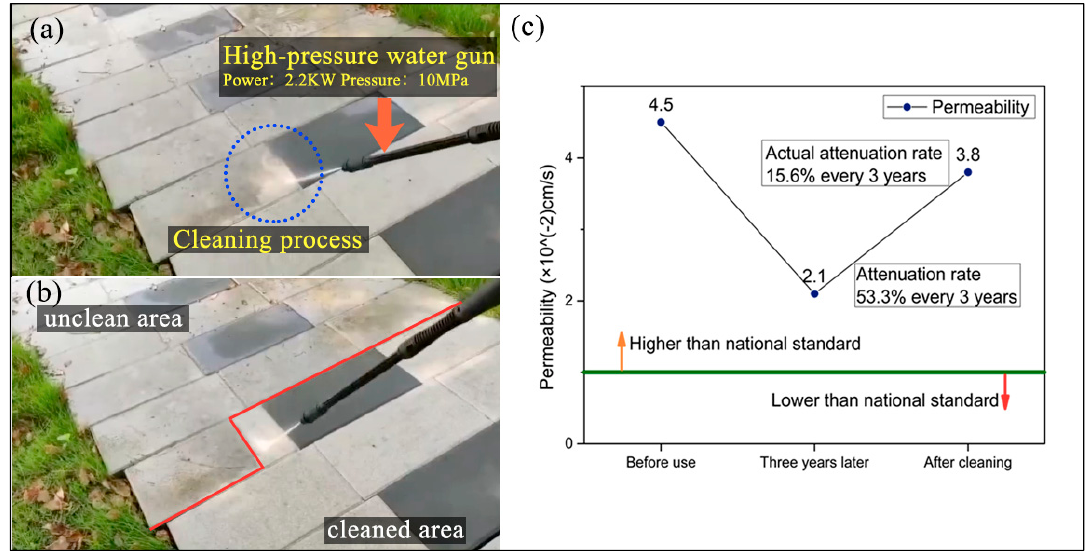
Figure 20. Long-term use of RBPB. ( a ) Cleaning process and tool of RBPB. ( b ) Comparison before and after cleaning. ( c ) Change of water permeability coefficient during use.